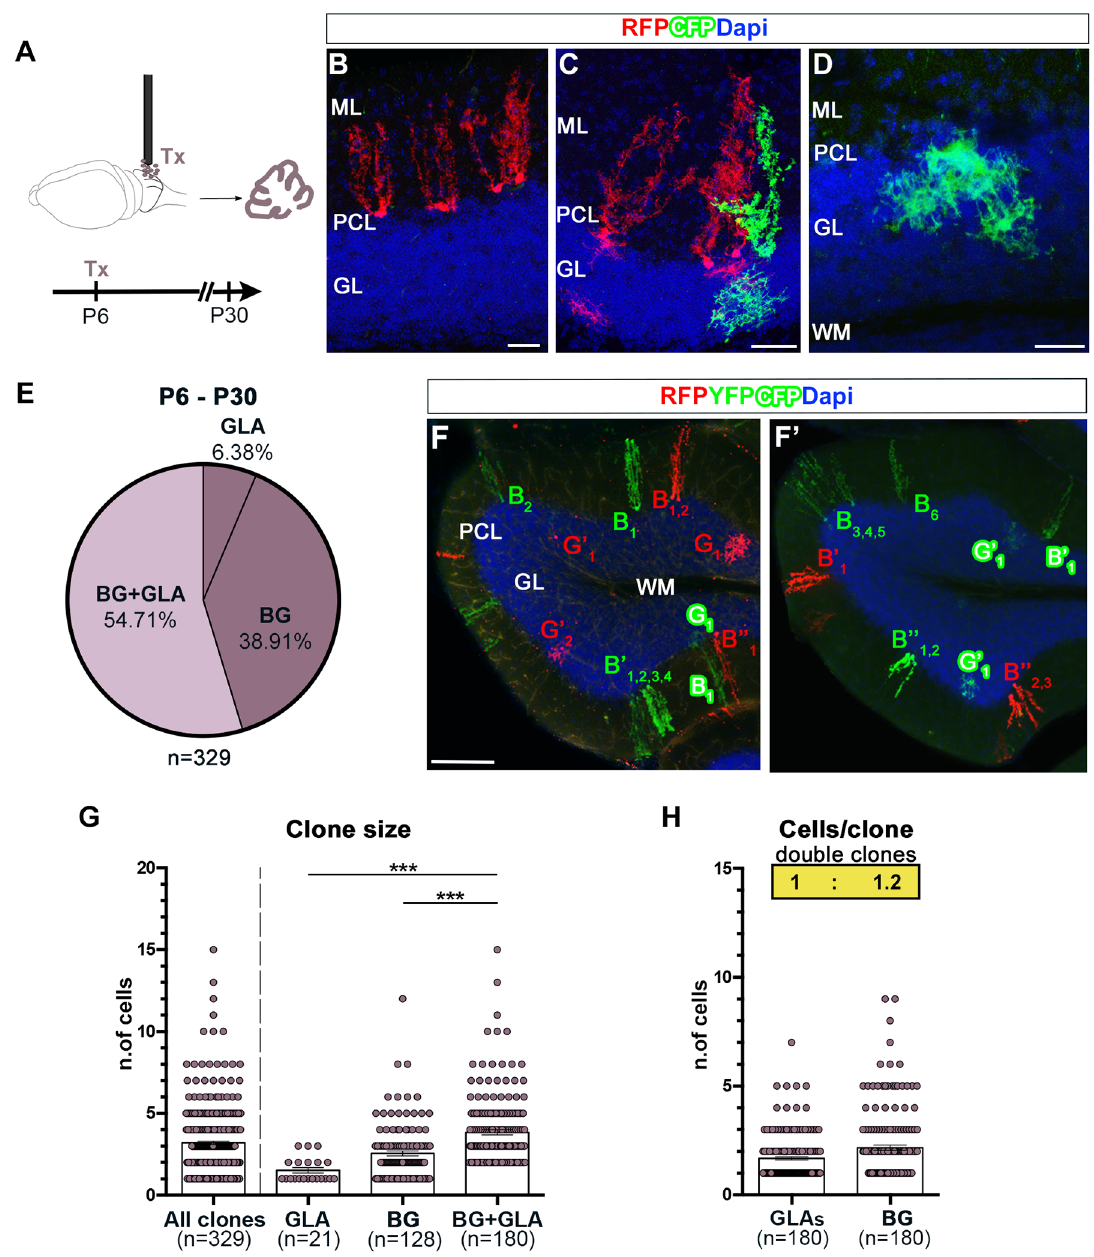
Fig 7. Analysis of PCLp progenies at P30. (A) Experimental design of superficial administration of Tx to induce R26R Confetti recombination in radial GLAST + precursors in the PCL (PCLps). (B-D) Analysis after serial sections’ reconstruction at P30 reveals the existence of sister astrocytes (i.e., expressing the same color) arranged in different clone types: BG clones (B), double clones composed of BG+GLA (C), and rare GLA clones (D). (E) Quantification of the relative proportion of each clone type derived from P6-tagged PCLps in lobule IV–V. Pies illustrate pooled data from 3 animals. (F,F’) Examples of clones distributed in 1 or 2 adjacent sections. (B = BG, G = GLA; superscripts indicate distinct clones; subscripts indicate sister cells). (G) Scatterplots of clone size. BG+GLA clones are bigger compared to clones composed of only BG or GLAs. (H) Scatterplots show the number of distinct astrocyte types in double clones. The insets report the clonewise stoichiometry, rounded to the first decimal, which highlights the prevalence of BG over GLA. (cid:3)(cid:3)(cid:3) , P < 0.001; P values are calculated with GEE analysis n = number of clones. Scale bars: 30 μ m (B-D), 100 μ m (F-F’). The numerical data used in panels (G,H) are included in S1 Data. BG, Bergmann glia; CFP, cyan fluorescent protein; DAPI, 4 0 ,6-diamidino-2-phenylindole; GEE, generalized estimating equations; GL, granular layer; GLA, granular layer astrocyte; GLAST, glutamate aspartate transporter; ML, molecular layer; PCL, Purkinje cell layer; PCLp, Purkinje cell layer precursor; RFP, red fluorescent protein; Tx, tamoxifen; WM, white matter; YFP, yellow fluorescent